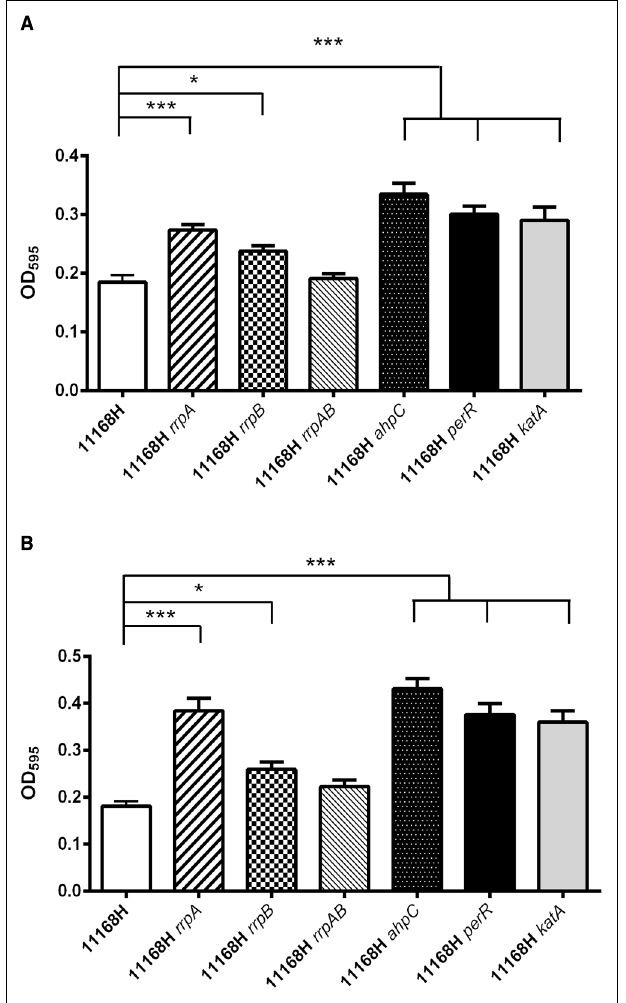
FIGURE 7 | Biofilm assays. C. jejuni 11168H wild-type strain and mutants were grown for 72 h under aerobic (A) or microaerobic (B) growth conditions at 37°C without shaking, rinsed three times with PBS, followed by crystal violet staining. Asterisks denote a statistically significant difference (* p < 0.05; *** p < 0.001).